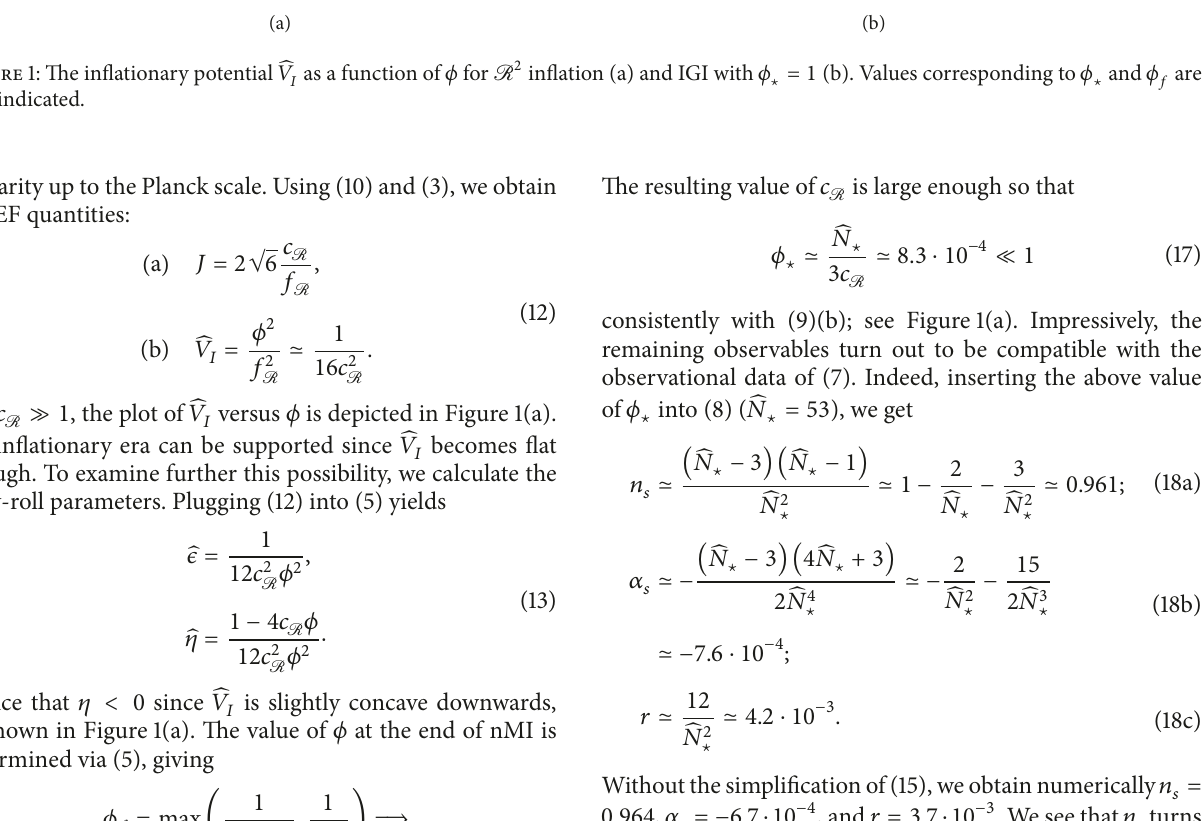
𝜙 for R 2 inflation (a) and IGI with 𝜙